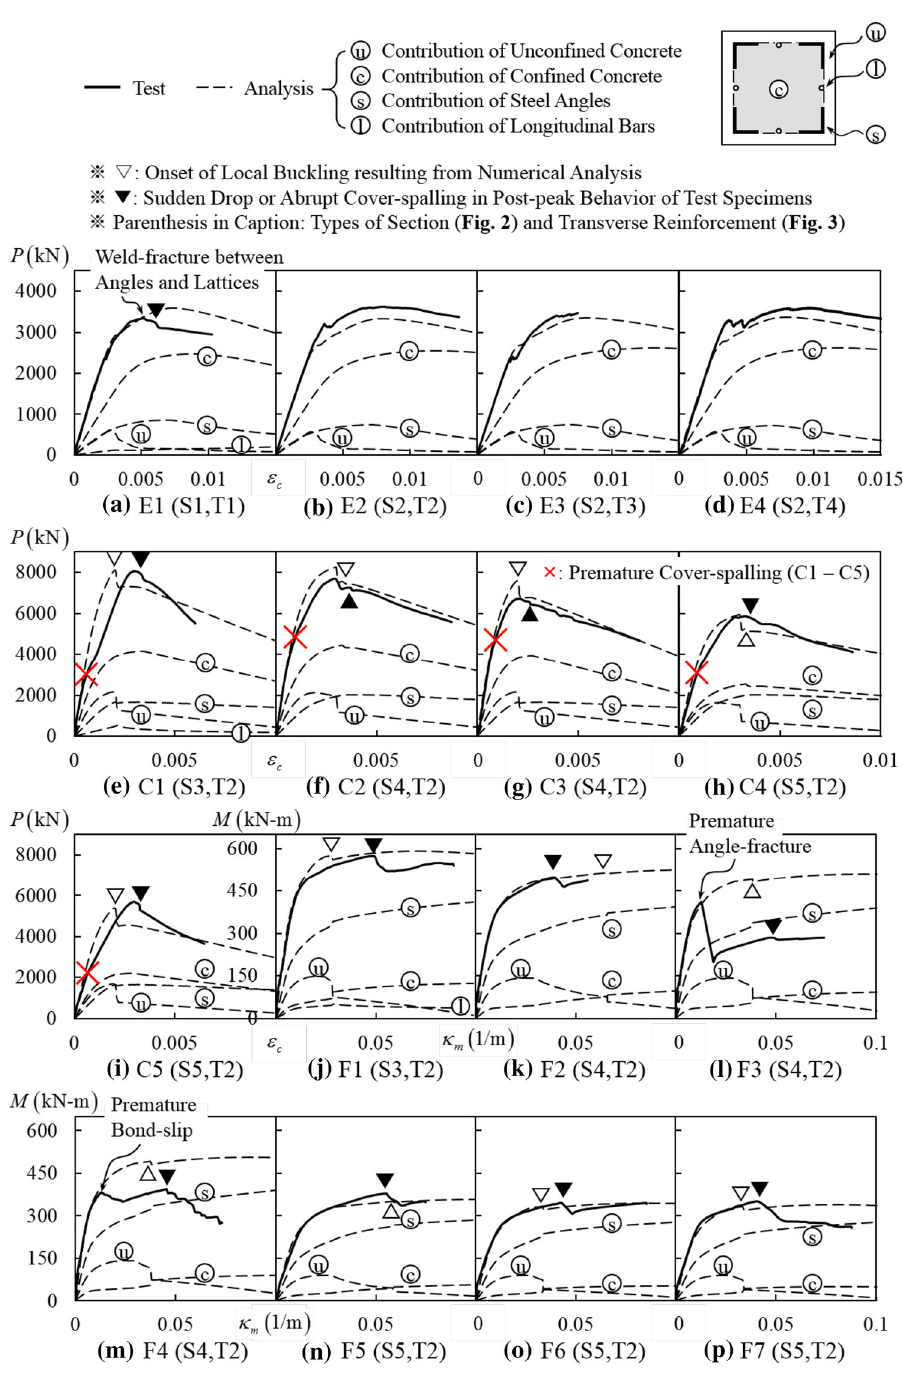
Fig. 9 Comparison of numerical analysis results with previous test results (evaluated at mid-height